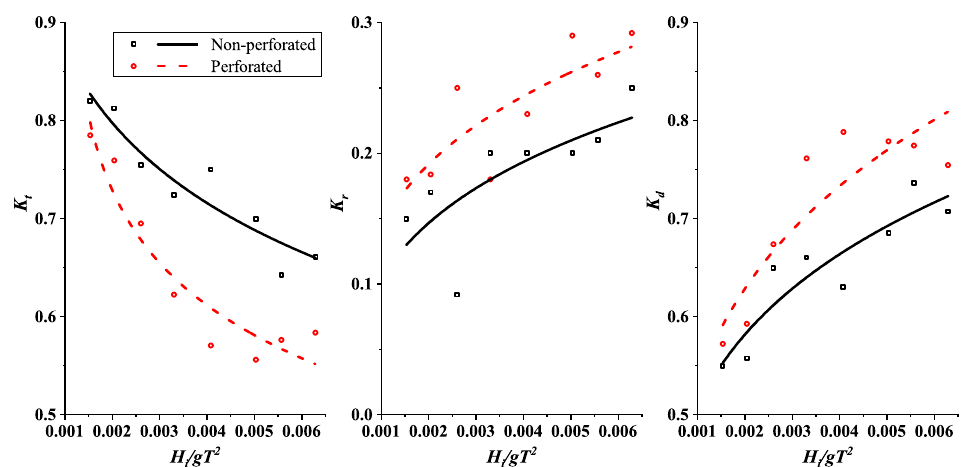
Figure 15. Performance comparison between non-perforated and perforated CPHBs.